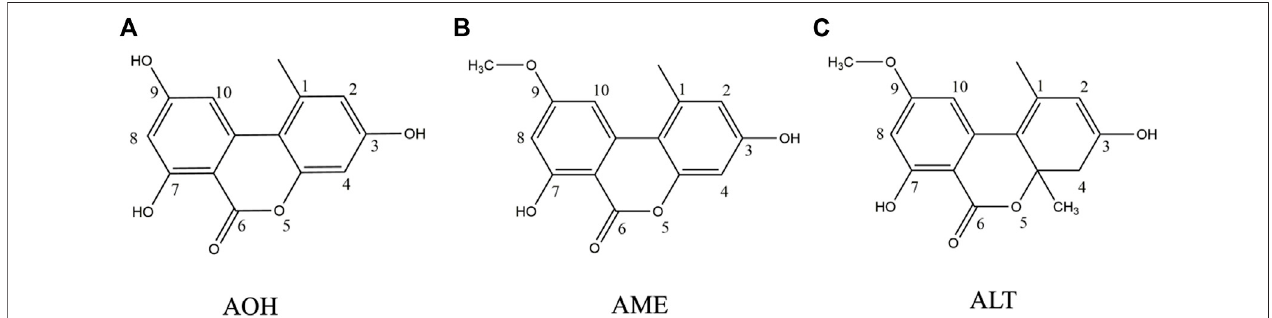
FIGURE 1 | Structure of three main Alternaria alternata mycotoxins. (A) Alternariol. (B) Alternariol monomethyl ether. (C)